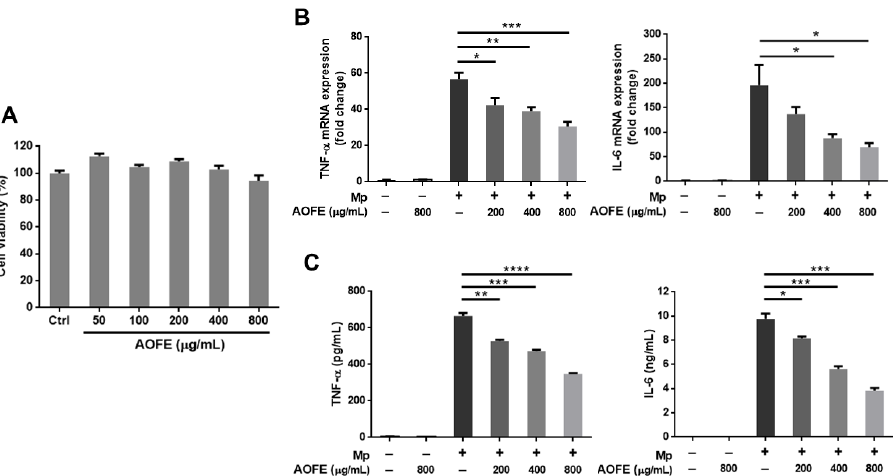
Figure 4. AOFE inhibits Mp-stimulated inflammatory response in MH-S cells. ( A ) MH-S cells were treated with different concentrations of AOFE for 20 h, and cell viability was assessed by MTT assay. Untreated cells served as the control. ( B , C ) MH-S cells were pre-treated with or without AOFE for 2 h, and the cells were stimulated with Mp (MOI = 100) for 4 h ( B ) or 20 h ( C ). Cells left untreated or treated with AOFE alone served as controls. At 4 h after Mp stimulation, total RNA was extracted from MH-S cells and analyzed for TNF- α and IL-6 mRNA expression by RT-qPCR ( B ). At 20 h after Mp stimulation, TNF- α and IL-6 levels in the culture fluids were determined by ELISA ( C ). All data shown are representative of two independent experiments with similar results ( n = 3). * p < 0.05, **